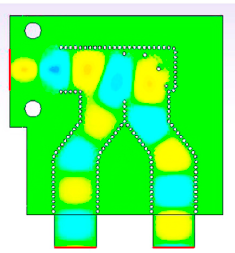
Figure 4. Electric field of two-way H-plane SIW power divider.